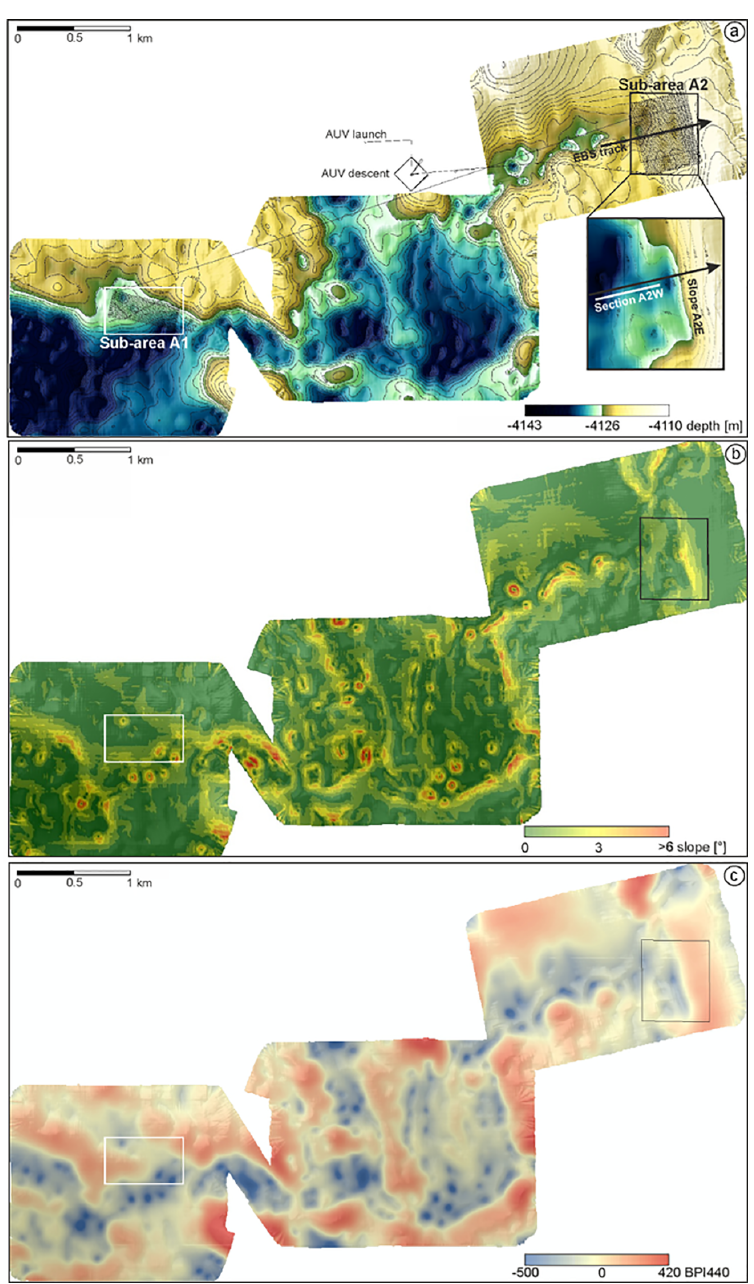
Figure 4. Bathymetric map obtained by the AUV, with the black line indicating the track of AUV Abyss Dive 168 prior to the EBS deploy- ment. The black arrow marks the tow track of the EBS deployment. (b) Slope map derived from bathymetry indicating maximum slopes of 10 ◦ ; (c) BPI map (BPI440) derived from AUV-obtained bathymetry. The black and white rectangles indicate the eastern and western